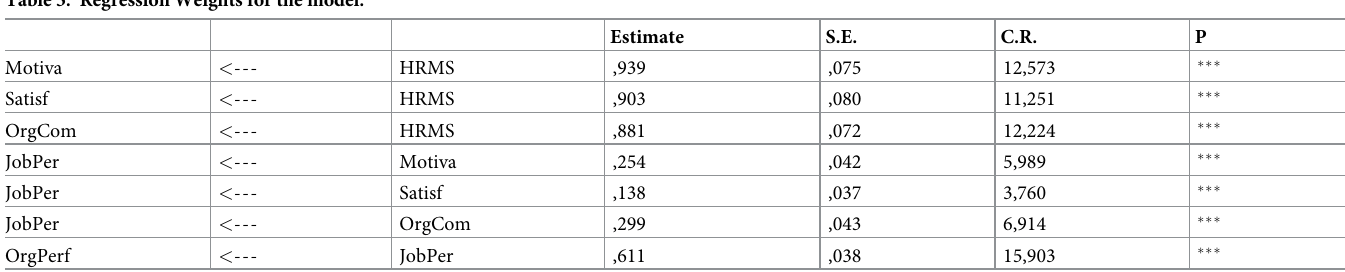
Table 5. Regression Weights for the model.